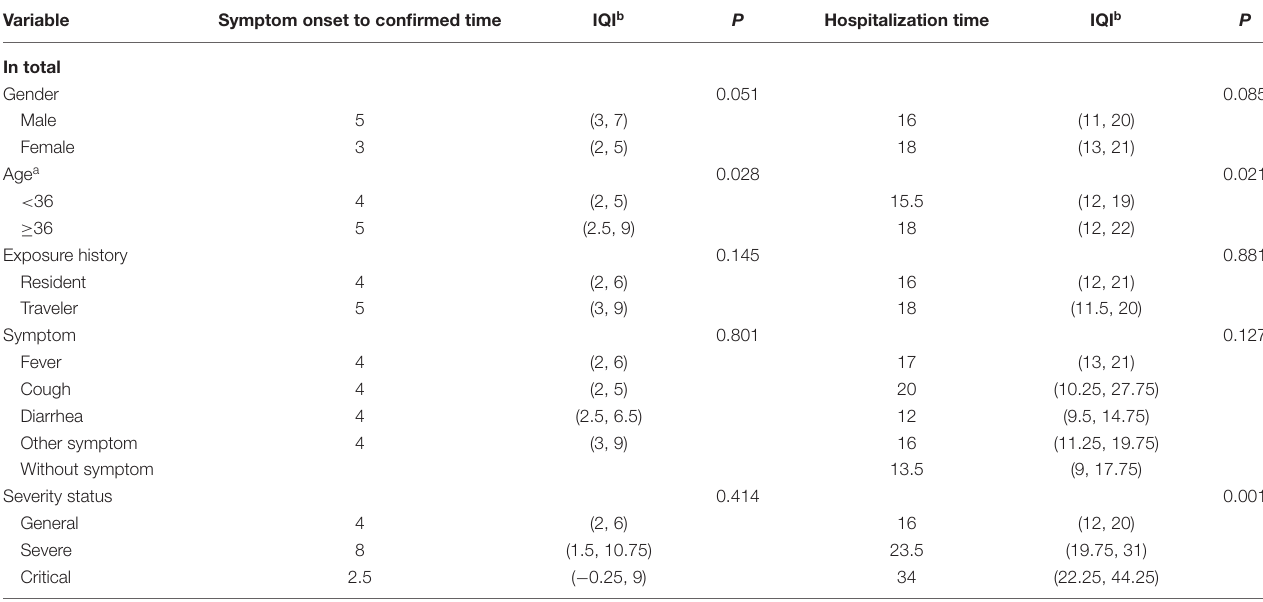
TABLE 2 | The epidemiological characteristics and clinical outcomes of patients diagnosed with COVID-19.